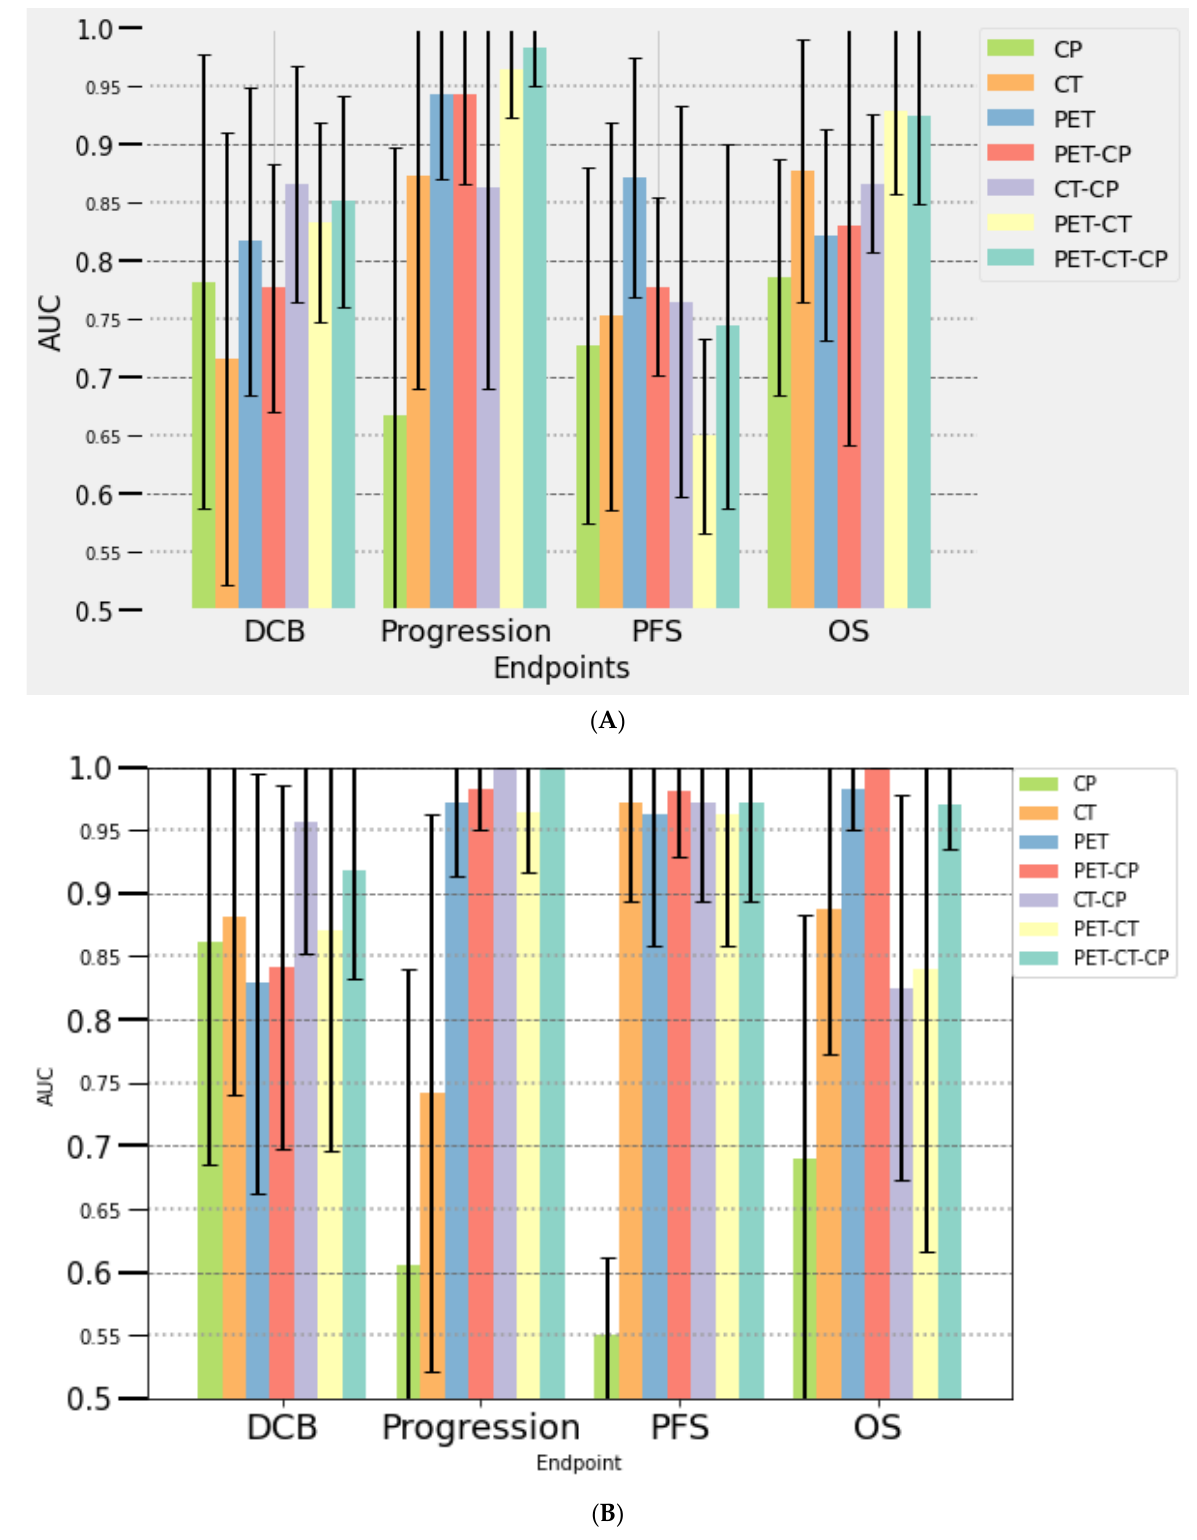
Figure 1. Performances of seven multi-parametric models for the prediction of outcome using clinical data (CP) and radiomics features derived from PET and CT at baseline ( A ) and at month 2 ( B ) in the training data set, with their standard deviations integrated. OS: overall survival; PFS: progression-free survival, DCB: durable clinical benefit.